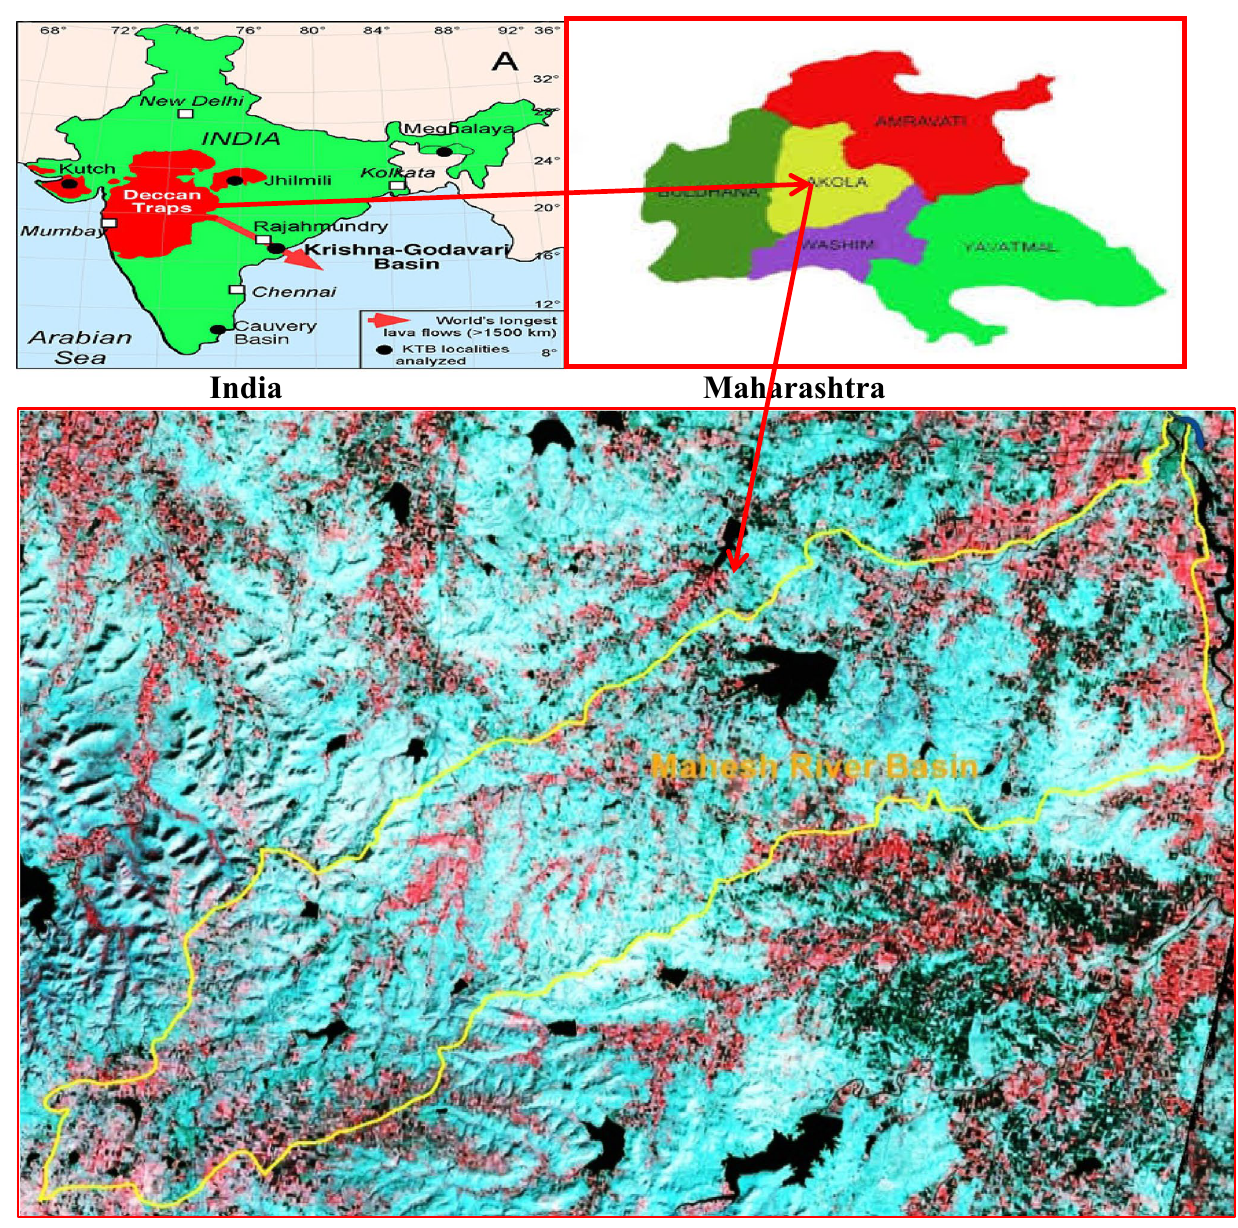
Fig. 1 Location map of Basaltic hard